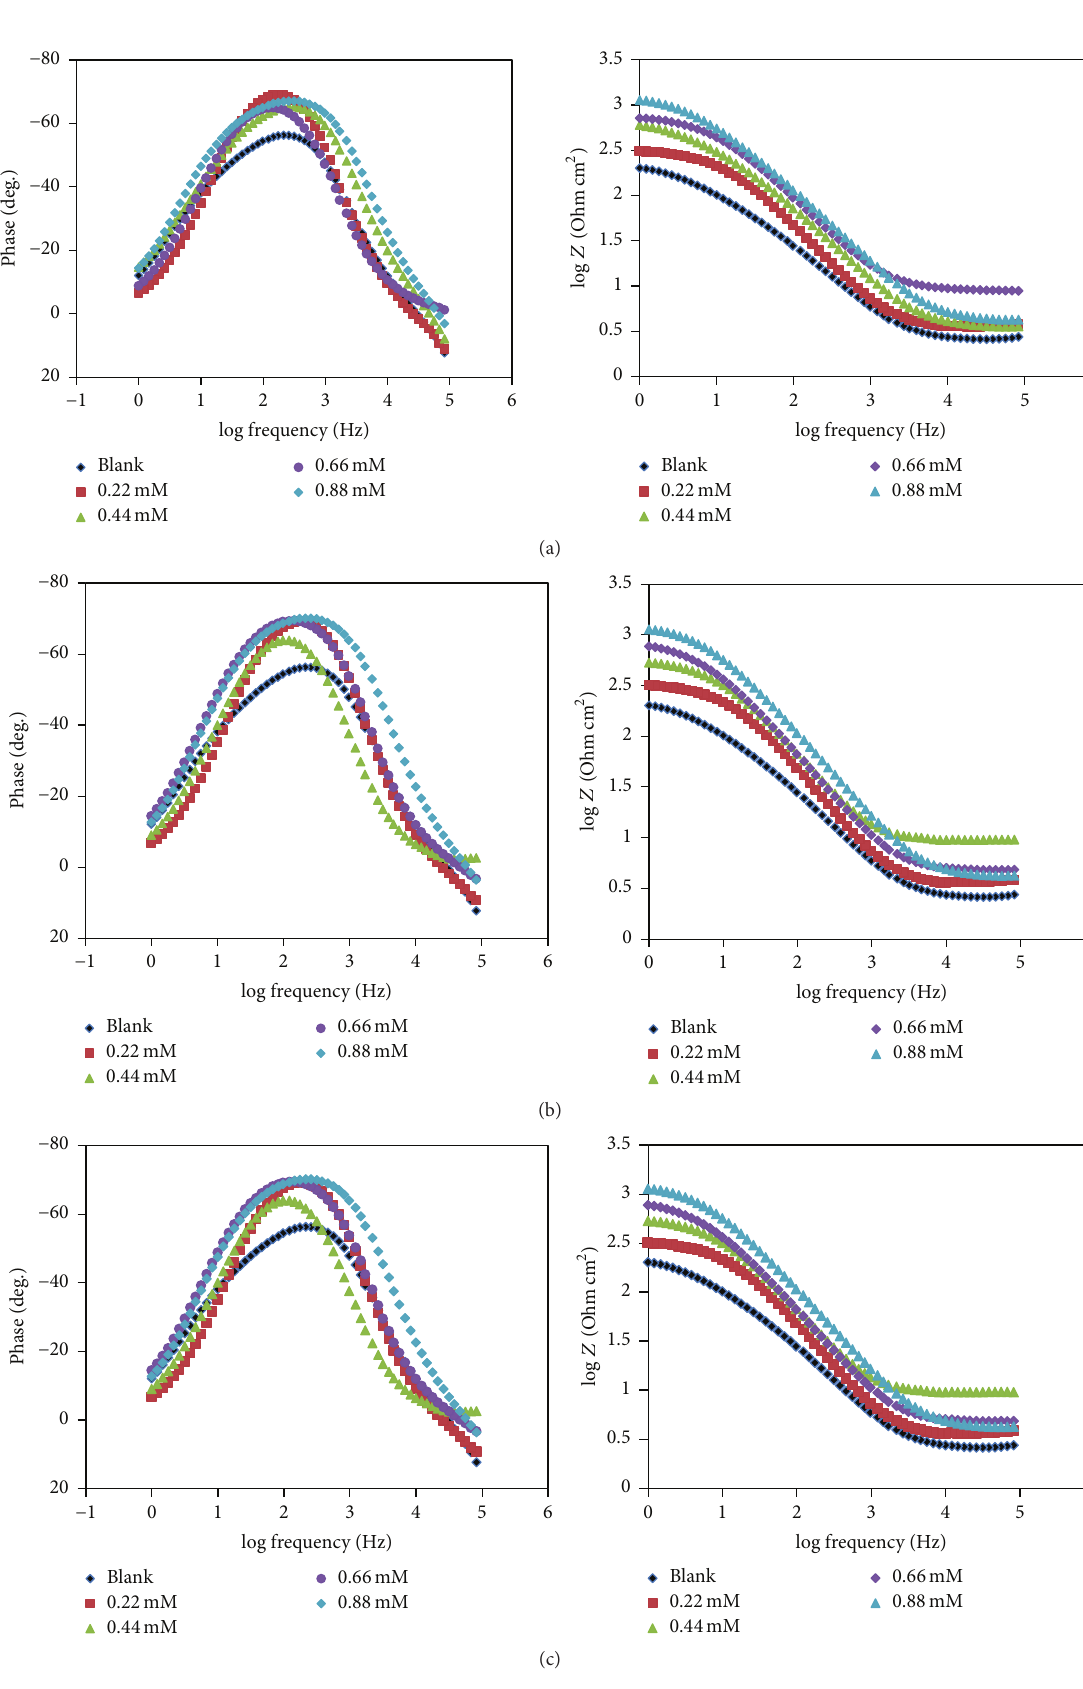
Figure 9: Bode plots in the absence and presence of different concentrations of (a) 2-MTPH, (b) 3-MTPH, and (c)